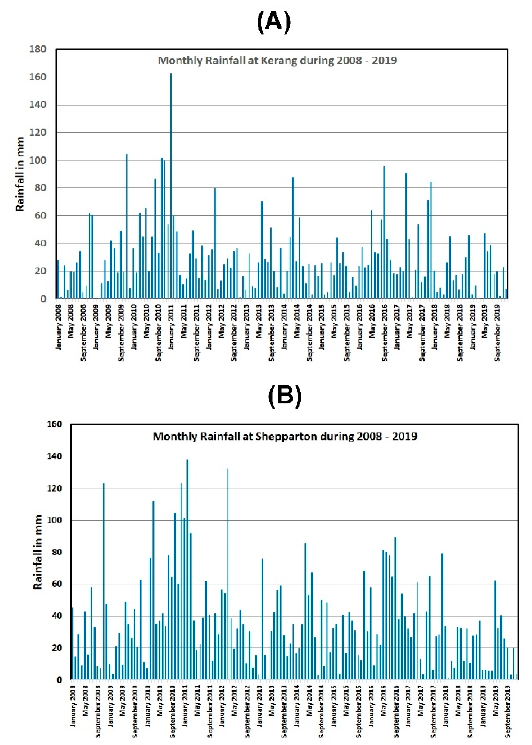
Figure 10. Monthly totals of rainfall during 2008–2009 and 2018–2019. ( A ) Kerang weather station (35.72 ◦ S; 143.92 ◦ E) located in the north-west of the study area. ( B ) Shepparton weather station (36.43 ◦ S; 145.39 ◦ E) located in the south-east of the study area.